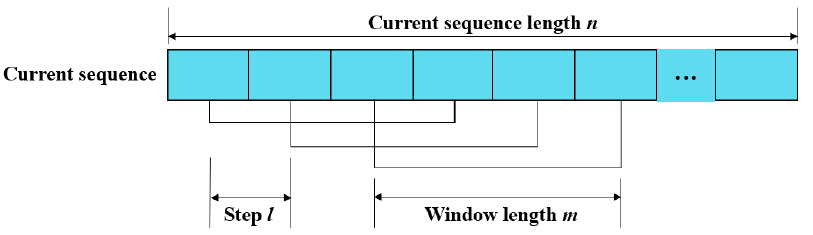
Figure 3. Principle of current sequence sliding window.